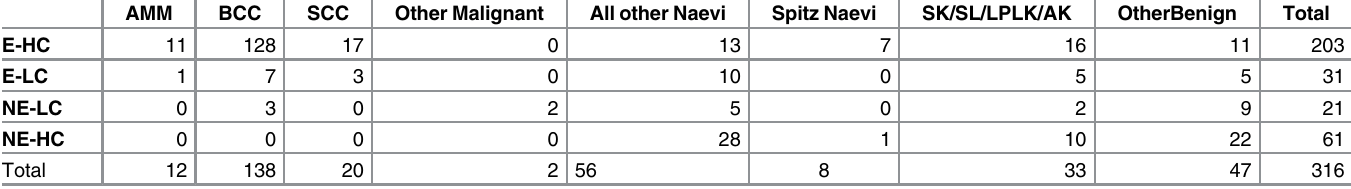
Table 4. Confidence level frequencies (Reader 3 – dermoscopy/RCM imaging).